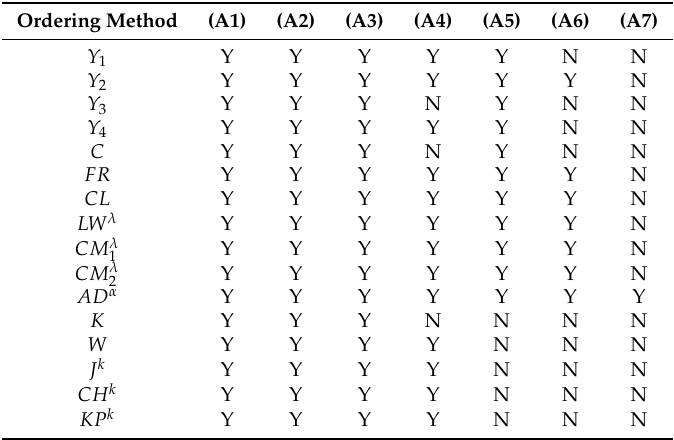
Table 1. Fulfilment of axioms for ordening methods discussed in